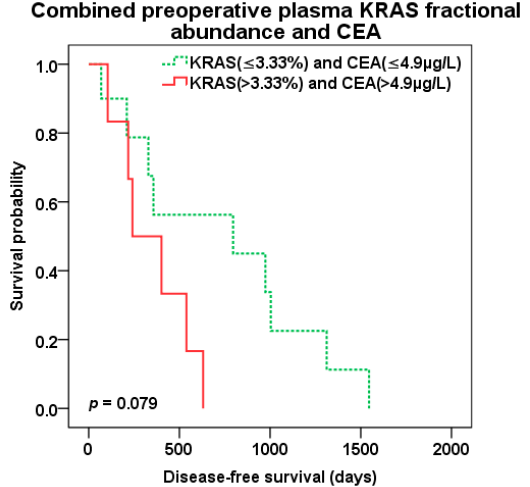
Figure 9. Disease-free survival (DFS) after liver surgery for patients with combined low (green color dotted line) vs. high (red color) preoperative KRAS pFA and CEA levels (cut-off 3.33% and 4.9 µg/L, resp.).